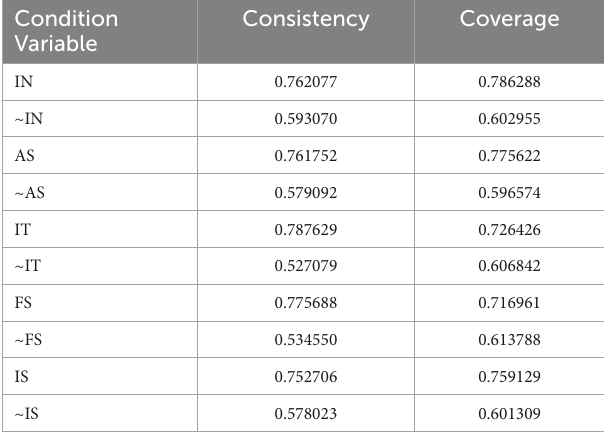
TABLE 6 Necessity test of single condition